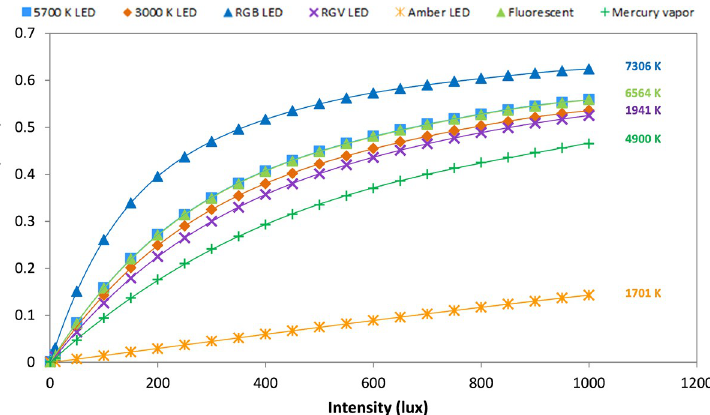
Fig 5. Simulations of melatonin suppression (equivalent to CS index) according to the Rea´s circadian light model [42] applied to different light sources and intensities. Light sources simulated were: the same two light conditions experimentally tested in this study (5700 K, blue square, and 3000 K LED, brown diamond, model squared Inspire 48W Gdansk, Leroy Merlin S.L., Lille, France), a red, green and blue monochromatic LED light (RGB, blue triangle, 7306 K), and a red, green and violet monochromatic LED light (RGV, purple cross, 1941 K) both of them manufactured at the University of Murcia electronic facilities, a commercial amber LED (orange cross, 1701 K, from Ignialight Sacopa S.A.U., Spain), a commercial fluorescent (green triangle, 6564 K, from ADEO, France) and mercury vapor (green cross, 4900 K, from Luxten, Romania) bulbs.